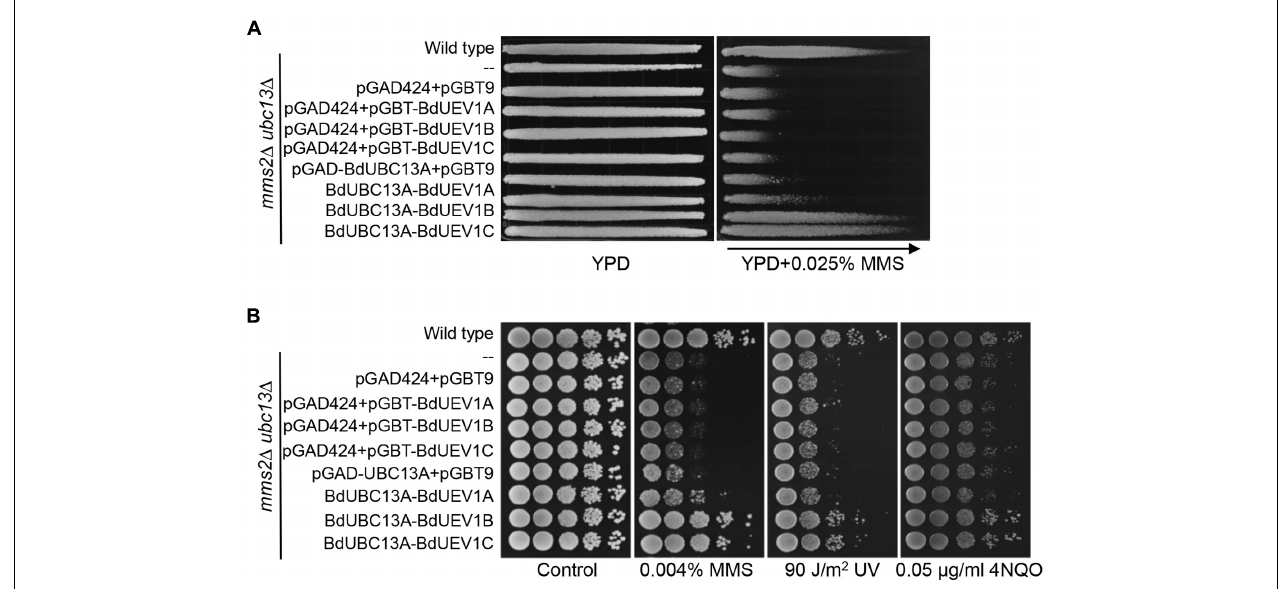
FIGURE 5 | Functional complementation of the yeast ubc13 mms2 null mutant by BdUEV1 s and BdUBC13A . (A) Complementation of the ubc13 mms2 double mutant by BdUEV1 s and BdUBC13A . Yeast strain HK578-10D (wild type) and the isogenic ubc13 (cid:49) mms2 (cid:49) transformants were grown overnight and then printed onto the gradient plate. The YPD control (left) and YPD + 0.025% MMS gradient (right) plates were incubated at 30 ◦ C for 3 days. Arrow points to increasing MMS concentration. (B) Functional complementation of the ubc13 mms2 double mutant by BdUBC13A and BdUEV1 s using representative DNA-damaging agents by a serial dilution assay. Yeast strains as indicated were grown overnight in SD selective media, diluted and treated with the DNA-damaging agents.